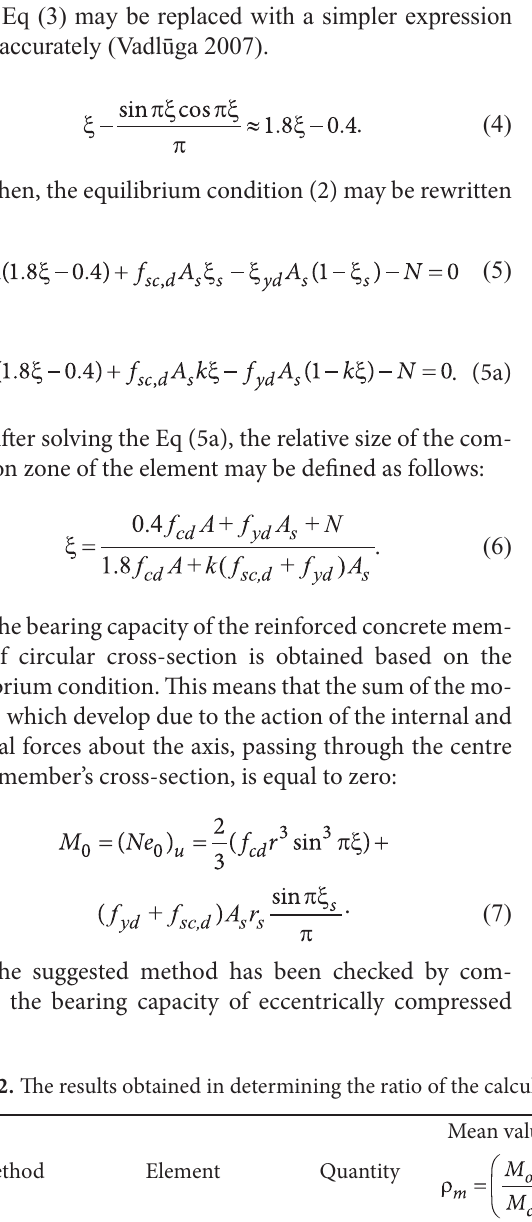
Table 2. The results obtained in determining the ratio of the calculated and experimental bearing capacity of the elements